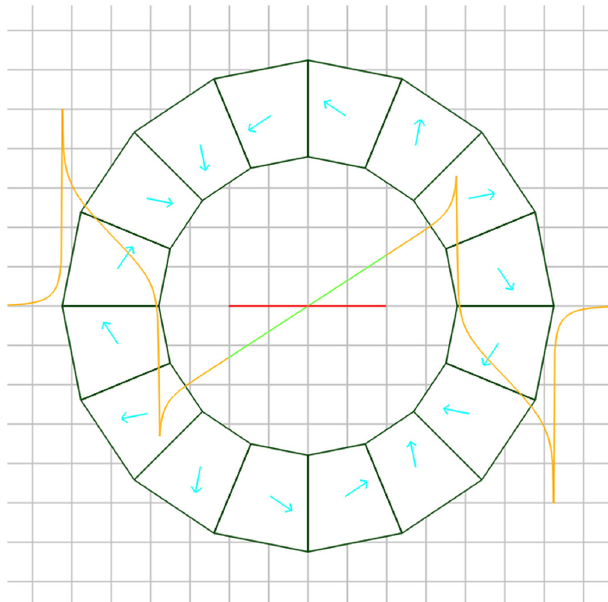
FIG. 4. Cross section of the quadrupole ‘ QF ’ magnet. Blue arrows show magnetization direction of the PM blocks. The orange line graphs the midplane field B y ð x; 0 Þ , with green highlighting the good field region and red showing the beam position range in the FFA. The grid has 1 cm spacing.